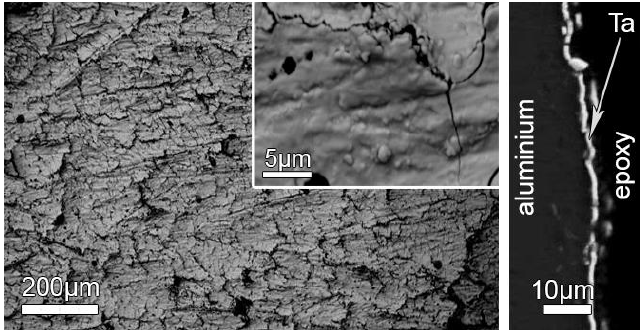
Figure 3. Surface microstructure (200 μm) and (5 μm) and cross-section view of tantalum coating on a gradient aluminum substrate ( t Cond = 390–420 °С).